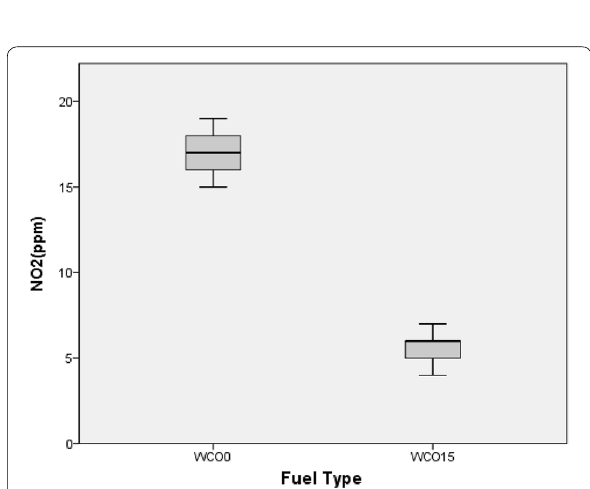
Fig. 6 Box plot diagrams of driving and exhaust characteristics [NO 2 emission (Unit: ppm)]